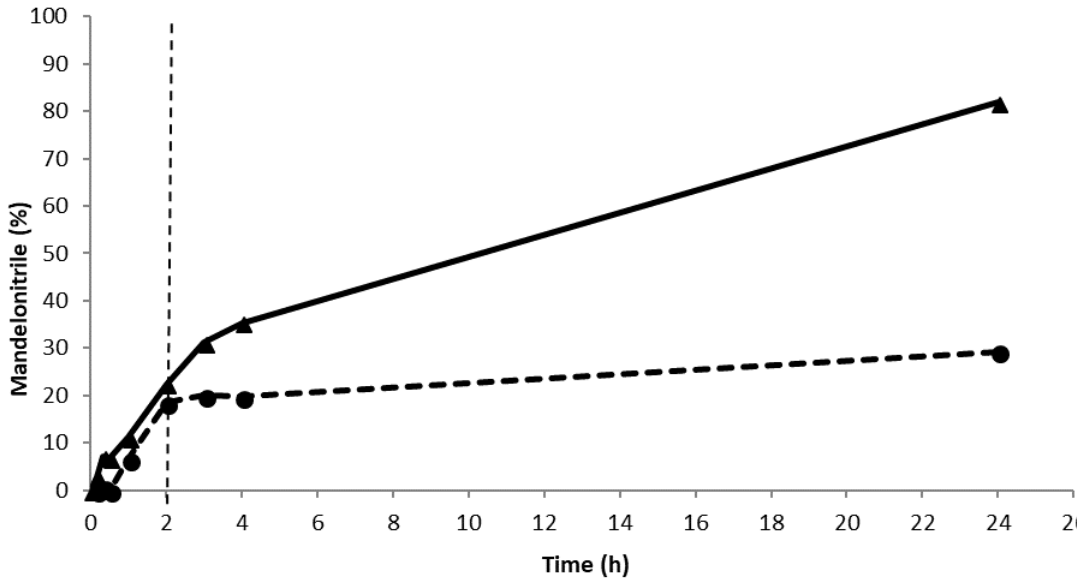
Figure 2. The leaching assays for Pa HNL. Conditions: benzaldehyde (±106 mg, 1 mmol), 2 ml HCN solution in methyl tert. Butyl ether (MTBE) (1.5 M), 1,3,5 ‐ triisopropylbenzene (±25 mg, internal standard) and a small, tightly packed teabag filled with Pa HNL immobilized on 50 mg Celite R ‐ 633 (9.2 U/mg). The reaction was stirred at 900 rpm at room temperature. ▲ and the solid line is the continuous reaction, ● and the dashed line is the reaction where the teabag with an immobilized enzyme was removed after 2 h.